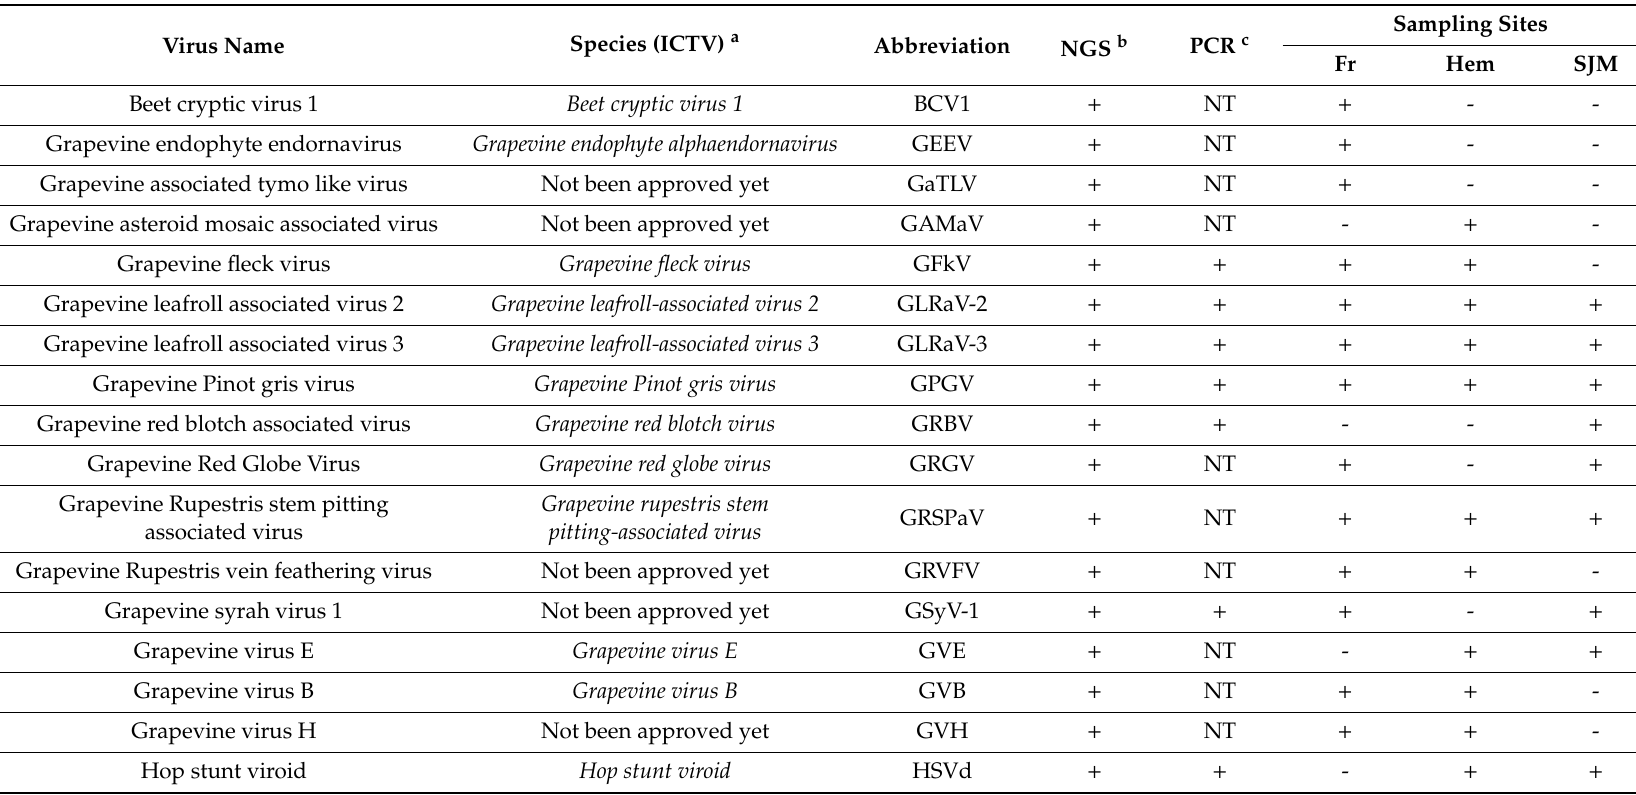
Table 1. Detection and description of viruses detected by dsRNA sequencing and confirmed by PCR reaction from composite samples of grapevine leaves collected at the two commercial vineyards (Hemmingford (Hem) and Saint-Jacques-le-Mineur (SJM)) and the experimental vineyard